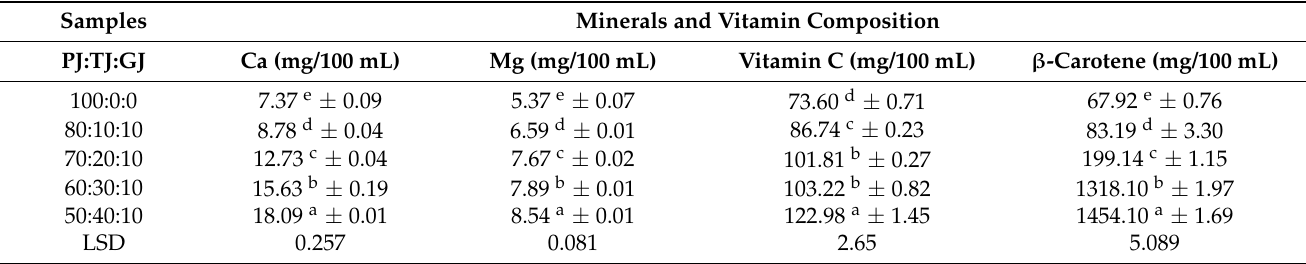
Table 2. Minerals and vitamins variations of Ginger, Pineapple, and Tumeric Juice Mix as influenced by Blends. Samples Minerals and Vitamin Composition